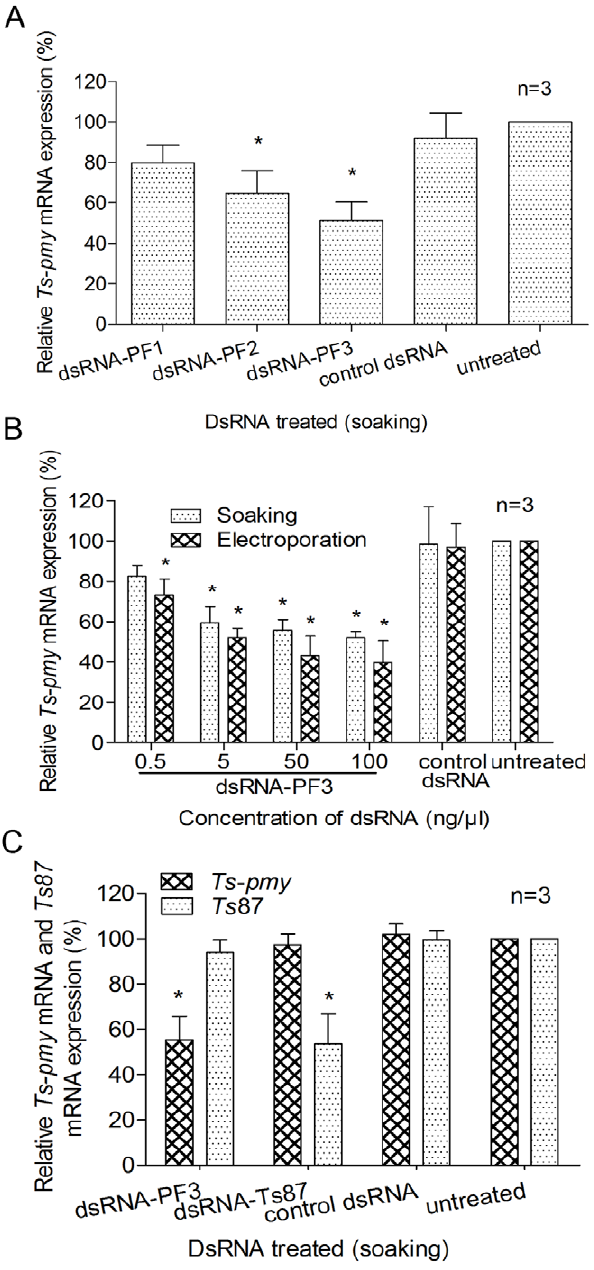
Figure 3. The silencing of Ts-pmy mRNA mediated by dsRNA. The relative level of Ts-pmy mRNA expression in larvae soaked with different dsRNAs (50 ng/ m l) for 6 days (A). The relative level of Ts-pmy mRNA in larvae following electroporation or soaking with various concentrations of dsRNA-PF3 for 6 days, as measured with qRT-PCR (B). Specific suppression of Ts-pmy and Ts 87 mRNA expression in larvae 6 days after being soaked with 50 ng/ m l dsRNA-PF3 or Ts 87 dsRNA (C). All of the assays were performed in triplicate, and the data are presented as the mean 6 SE. * p , 0.05 compared with the control dsRNA-treated